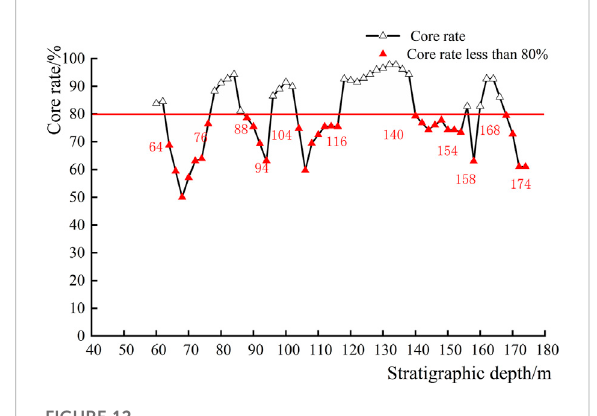
FIGURE 12 Relationship between the drilling depth and the core ratio at point 3 of the Y 3 line.